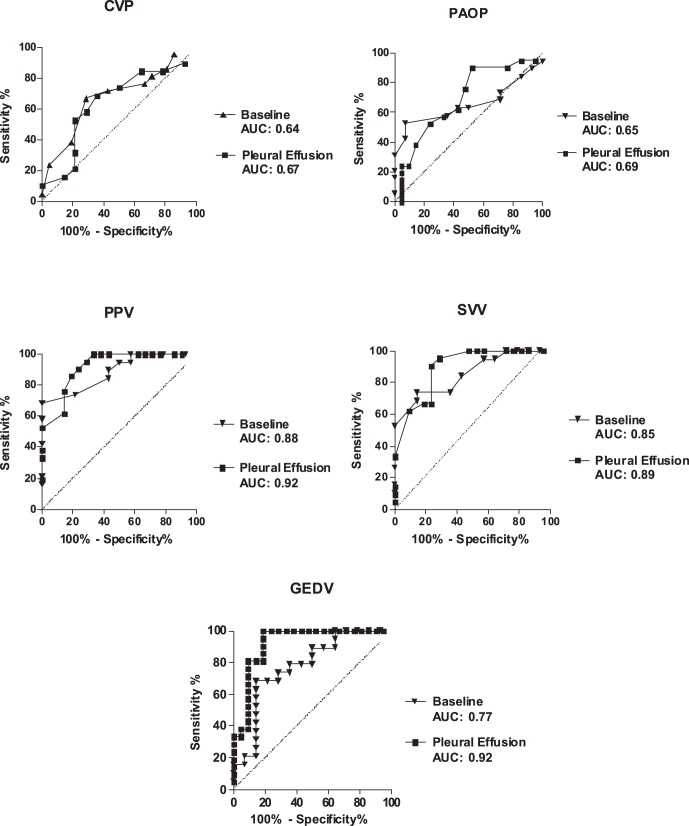
Prediction of fluid responsiveness at baseline and during pleural effusion:Area under the ROC curve (AUC). Ability of variables for predicting a ≥15% increase in stroke volume by pulmonary thermodilution (ΔSVPAC ≥15%). PAOP, pulmonary artery occlusion pressure; CVP, central venous pressure; PPV, pulse pressure variation; SVV, stroke volume variation; GEDV, global end-diastolic volume. The straight line indicates line of identity. AUC = 0.5: prediction of fluid responsiveness not better than chance; AUC = 1.0: best prediction.